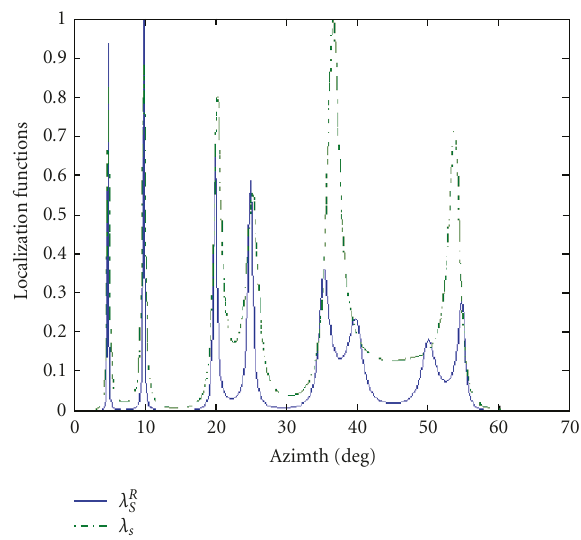
Figure 9: EG method as a function of the threshold values λ R λ s with m = 10 and SNR = − 5